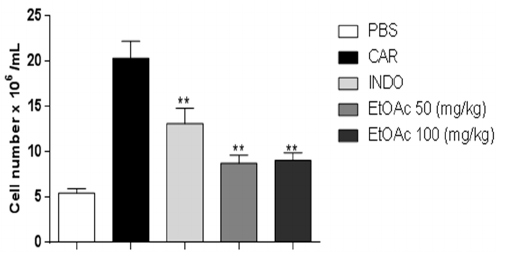
Figure 6. Reduction of total cell count in the presence of the EtOAc of A. occidentale . Statistical analysis performed using Student´s t -test. ** p < 0.01.